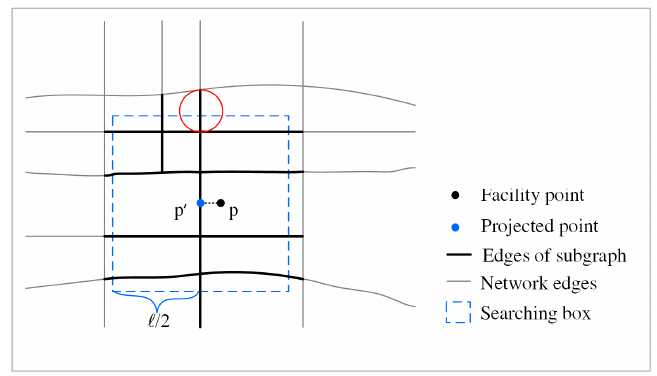
Figure 2. Example of subgraph construction of a facility.